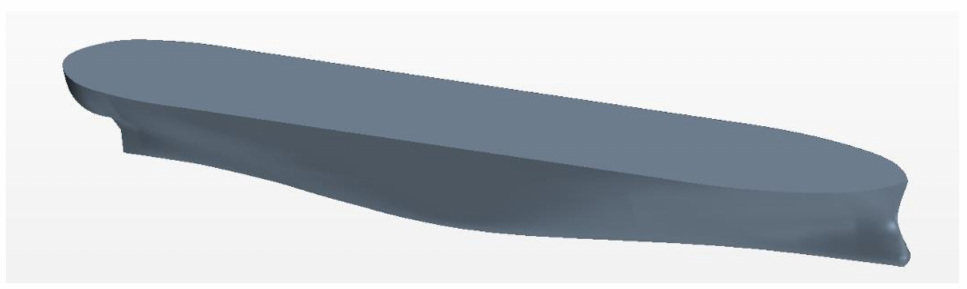
Figure 3. A 3D view of the model